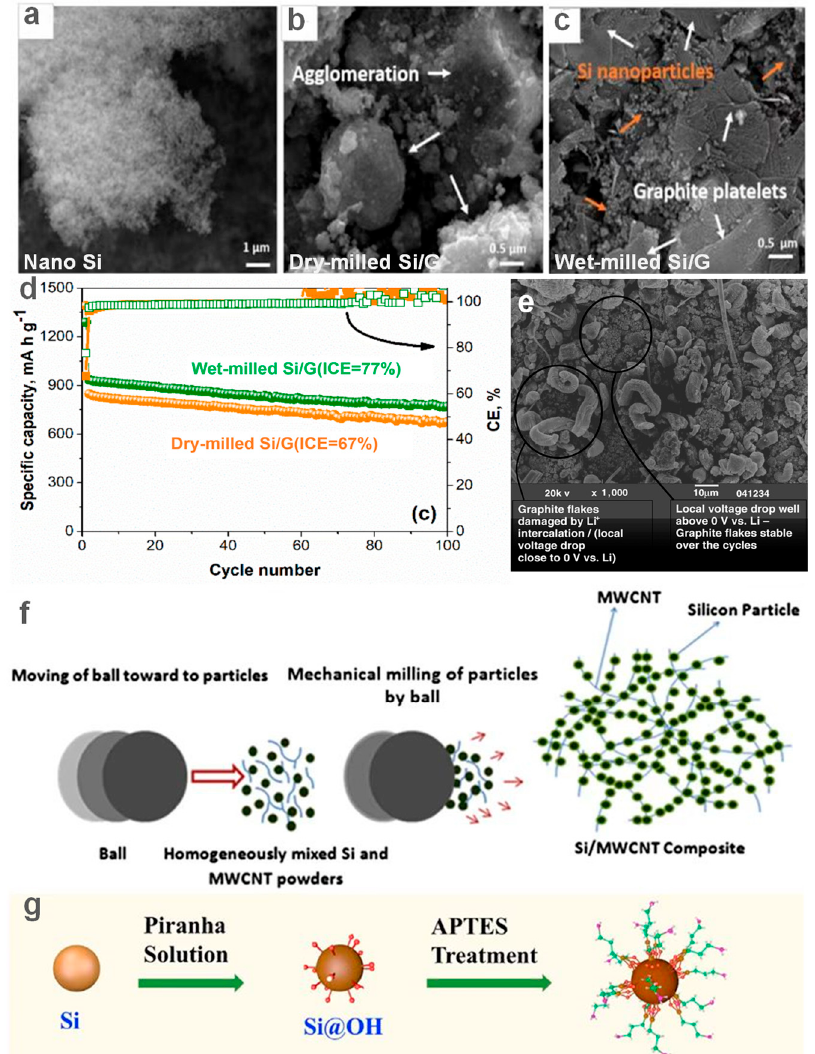
Figure 2. Scanning electron microscopy (SEM) micrographs of ( a ) Si nanoparticles (Alfa Aesar), ( b ) s-BMD, and ( c ) s-BMW. ( d ) Coulombic efficiency (CE) (squares) and specific capacity (spheres) vs. cycle number of e-BMD (orange) and e-BMW (green). The initial coulombic efficiency (ICE) is shown. Reproduced with permission [59]. Copyright 2020, MDPI. ( e ) SEM image of a graphite elec-